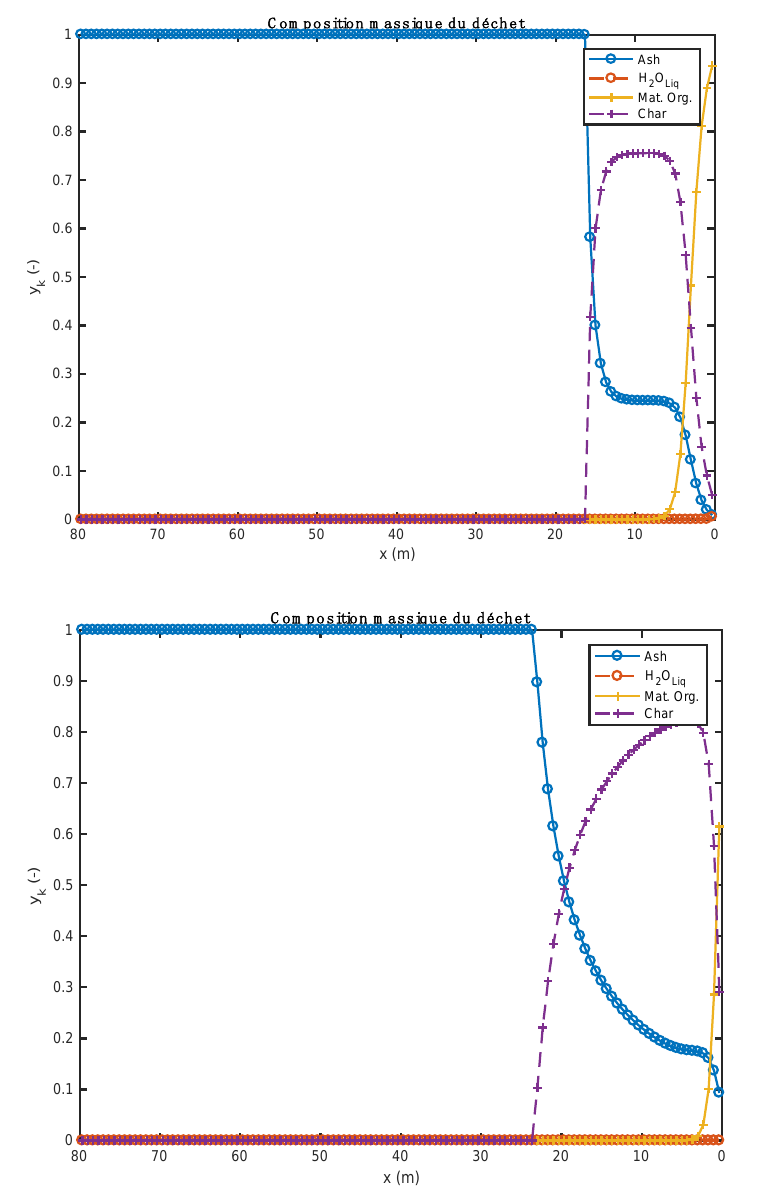
Figure 5. Comparison of waste composition profiles obtained with two alternative fuels (above: biomass; below: tires).